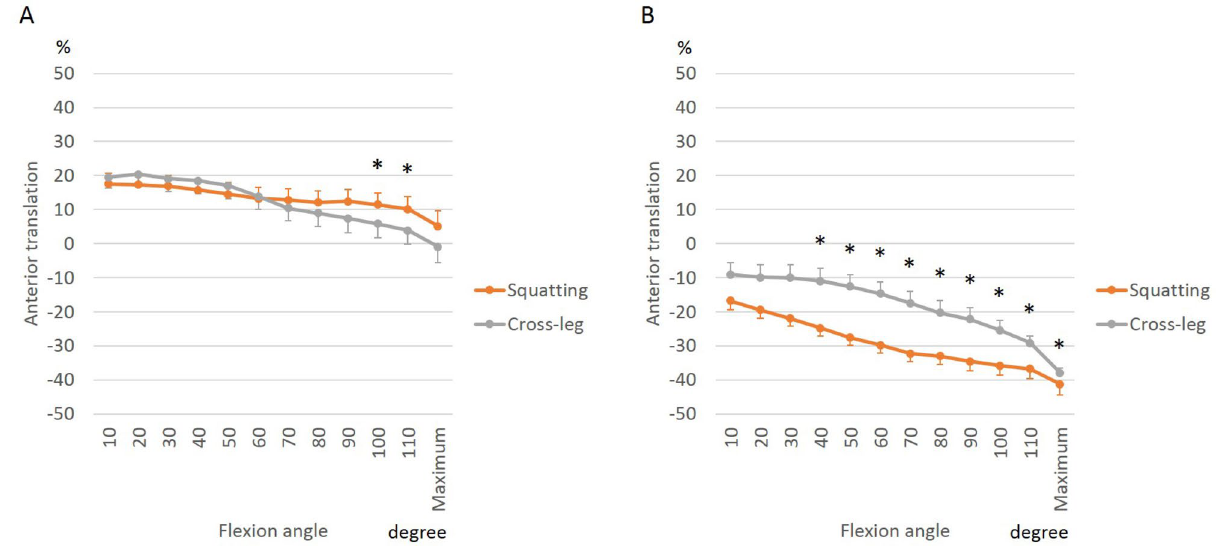
Figure 4. Differences between femoral AP translation of medial ( A ) and lateral ( B ) femoral condyle between squatting and cross-legged sitting.